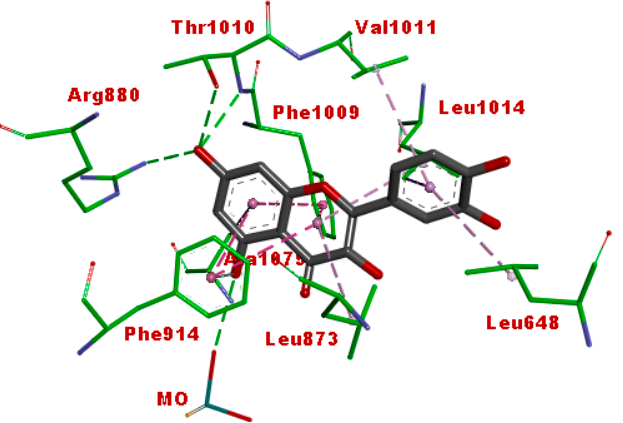
Figure 8. Binding interaction of quercetin (co-crystallized ligand) with the active site residues of xanthine oxidase (protein data bank (PDB) code: 3NVY). Green and purple dashes represent hydrogen-bonding and hydrophobic interactions, respectively.